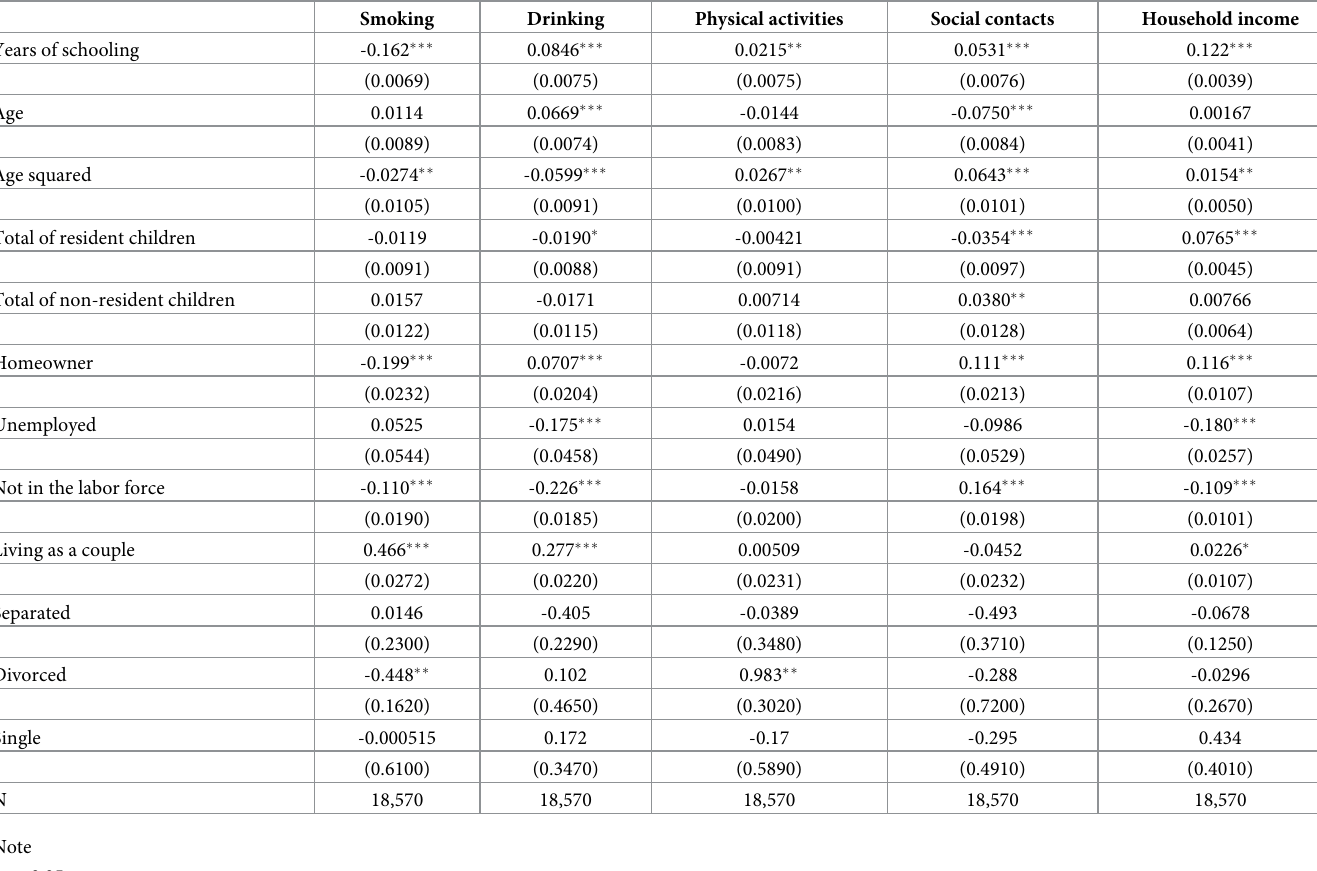
Table 6. Education and health behaviors, social contacts and